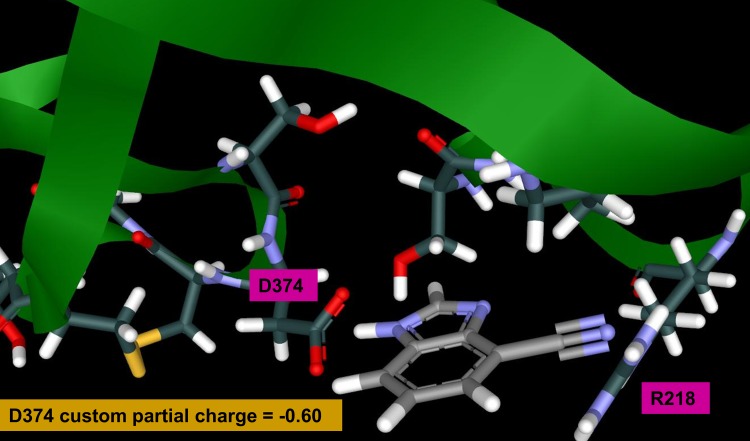
Cyano-benzimidazole is predicted to bind with the highest affinity (lowest chemical potential) at D374 of PCSK9.The GAMESS/RESP calculations on this configuration show that the sum of partial charges on D374 is reduced by 40%.